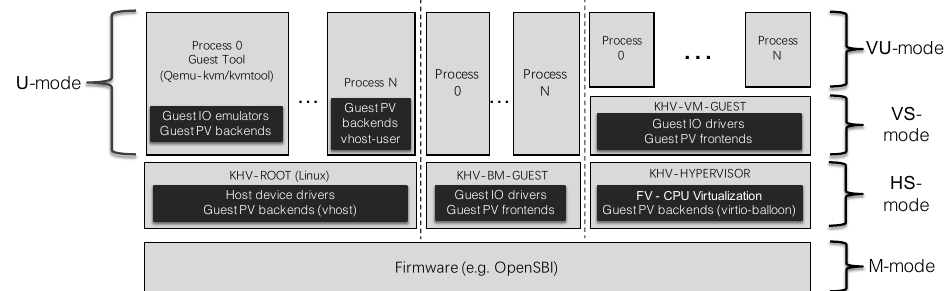
Figure 5. KHV on